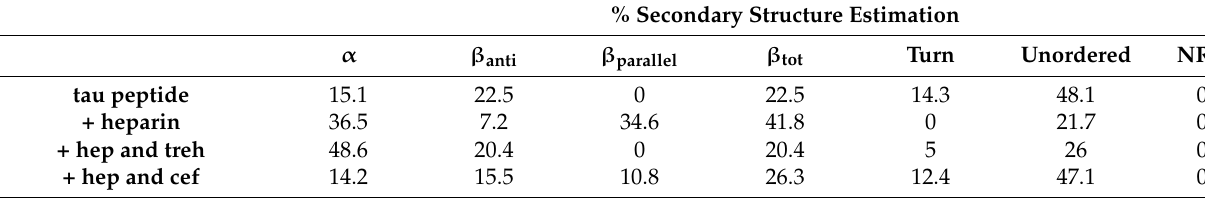
Table 1. Percentage of secondary structure content of tau peptide after 7 h of incubation at 25 ◦ C in presence of different molecules, along with the normalized root mean square error deviation (NRMSD) associated with the calculation.